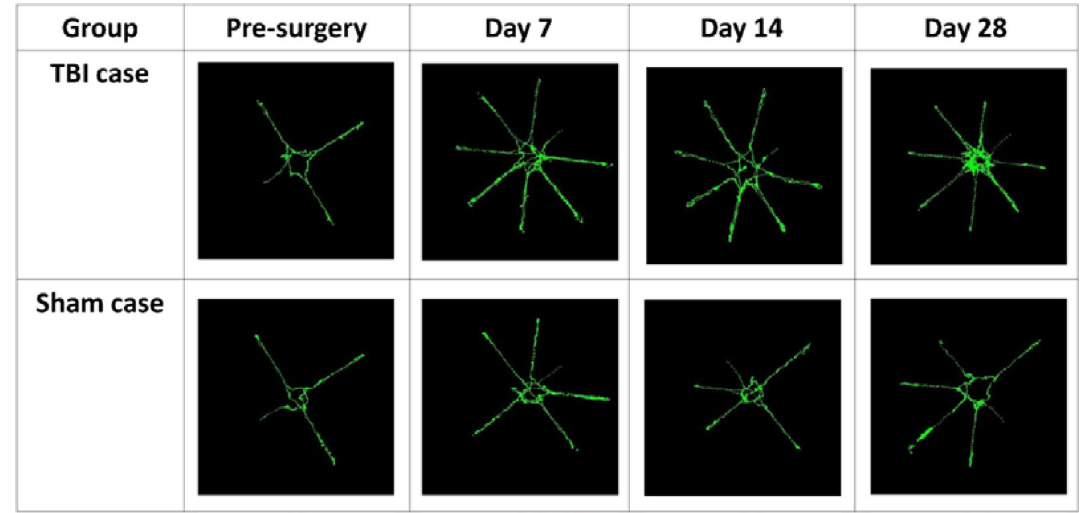
Figure 12. Food search trajectory comparison between the TBI and sham group over the course of 1